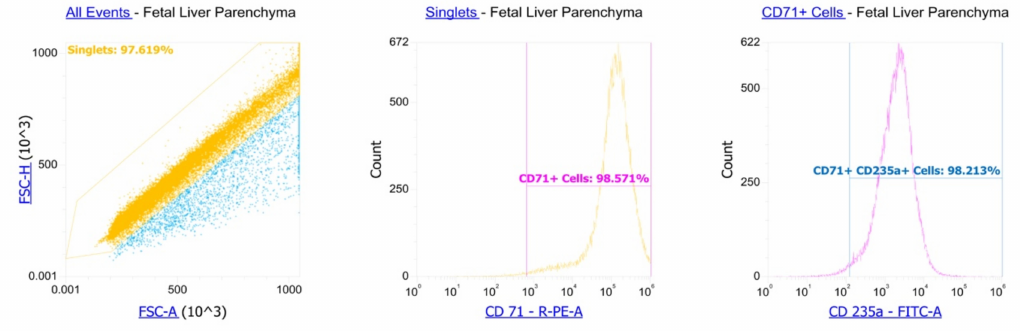
Figure 1. Human fetal liver parenchyma CECs’ purity assessment by flow